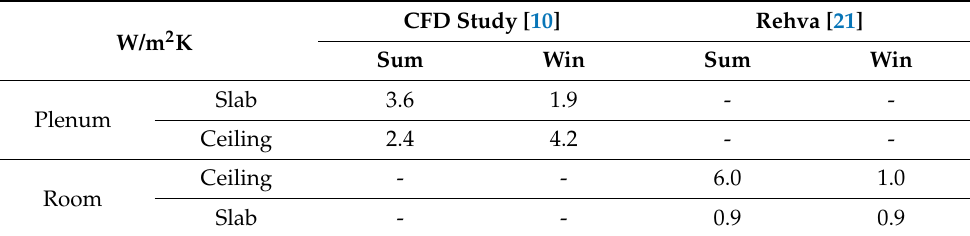
Table 2. Convective heat transfer coefficients used in IDA ICE. CFD Study [10] Rehva [21] W/m 2 K Sum Win Sum Win Slab 3.6 - Plenum Ceiling 2.4 - Ceiling - - Room Slab